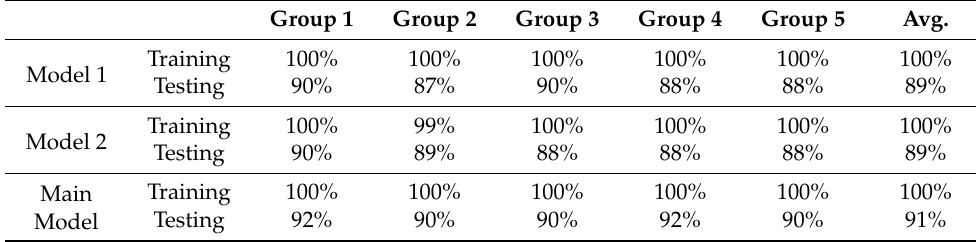
Table 3. Accuracy rate of Models.